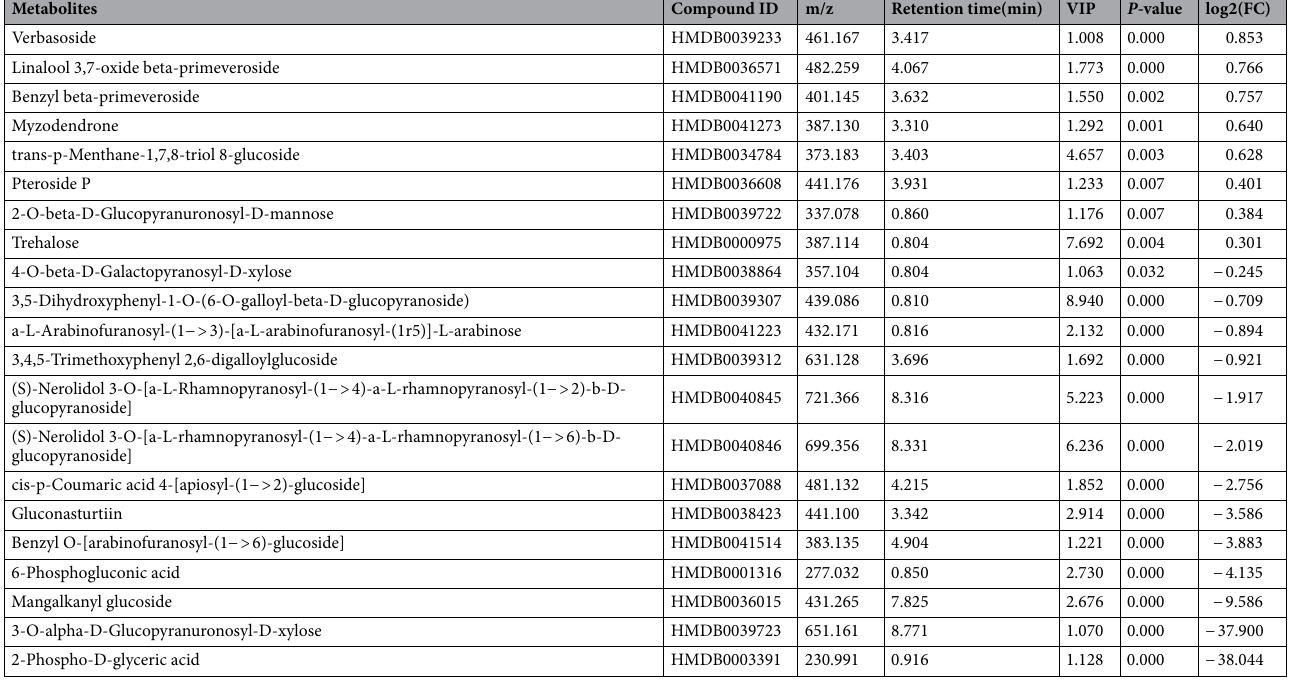
Table 1. Information of organooxygen compounds with significant